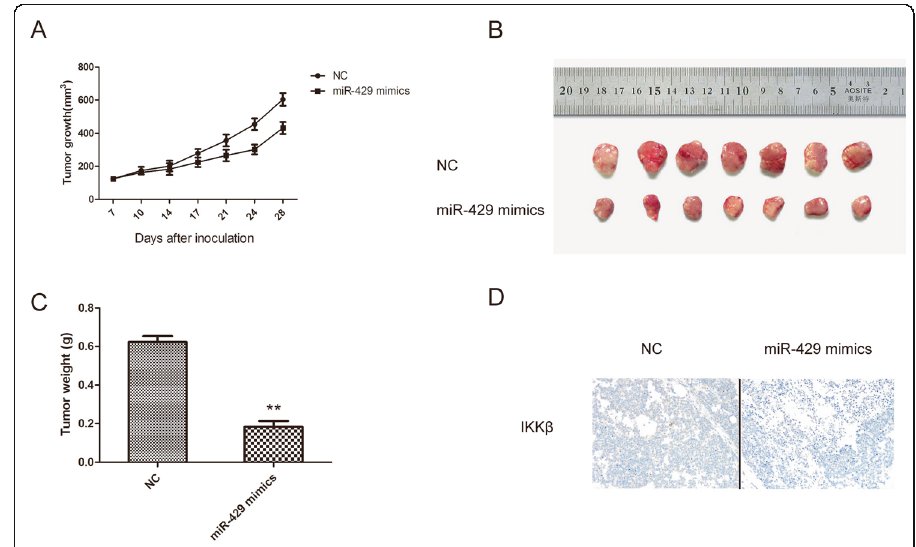
Fig. 6 miR-429 overexpression inhibited neuroblastoma growth in a nude mouse xenograft model. The mice were randomly assigned to the control or experimental group (five mice per group). Then, 2 × 10 6 of the NC or miR-429 mimic SH-SY5Y cells subcutaneously injected into the nude mice. a – Tumor volume was calculated twice weekly. b – Photographs of tumors derived from NC and miR-429 mimic cells in nude mice. c – Weights of tumors. d – IKK β expression was examined in xenografts that were treated with or without miR-429 mimic-transfected cells. Error bars represent the means ± SEM of at least three independent experiments. N.S.: not significant; * p < 0.05 and ** p < 0.01 vs. the control